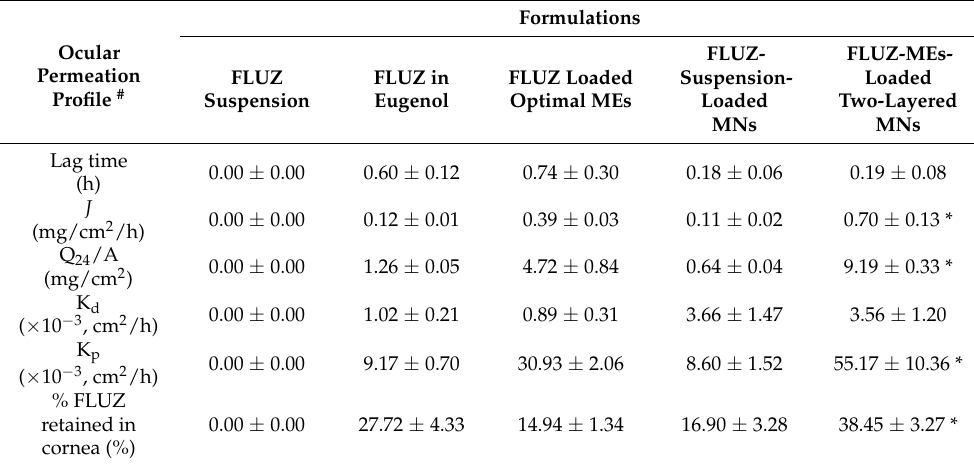
Figure 8. The percentage of FLUZ permeation in 24 h through porcine corneal tissues from different formulations. * indicates significantly higher than other formulations ( p < 0.05). Table 4. Ocular permeation profile and drug retained in corneal tissue of